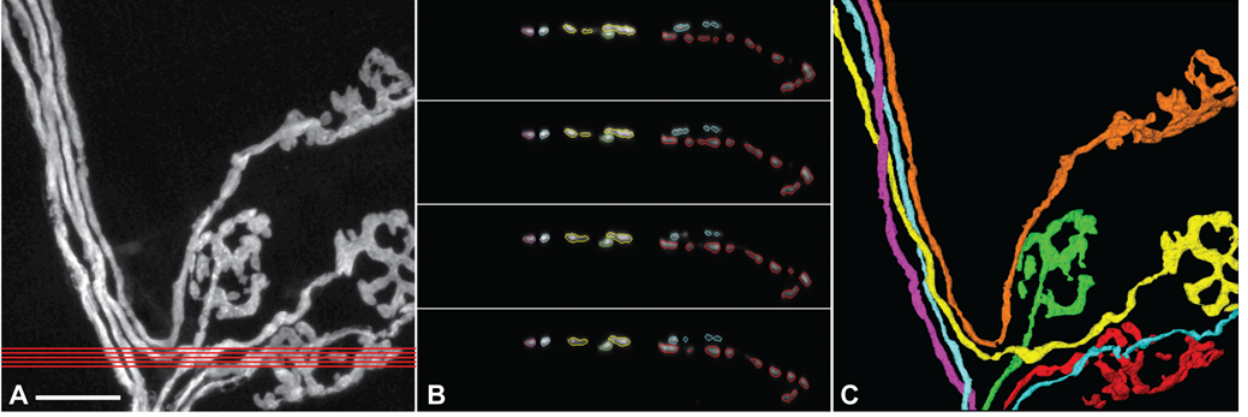
Figure 4. Example of axons traveling perpendicular to the preferred axis. A . Maximum intensity projection of a stack in which some axons lay parallel or oblique to the cross-sections. Red lines indicate the orientation as well as the position of virtual sections shown in B . Scale bar: 20 m m. B . Virtual sections of the region between the red lines in A . Part of the yellow axon traveled parallel to the virtual sections and appeared as multiple disconnected segments in successive sections. C . 3D rendering of all axons in this